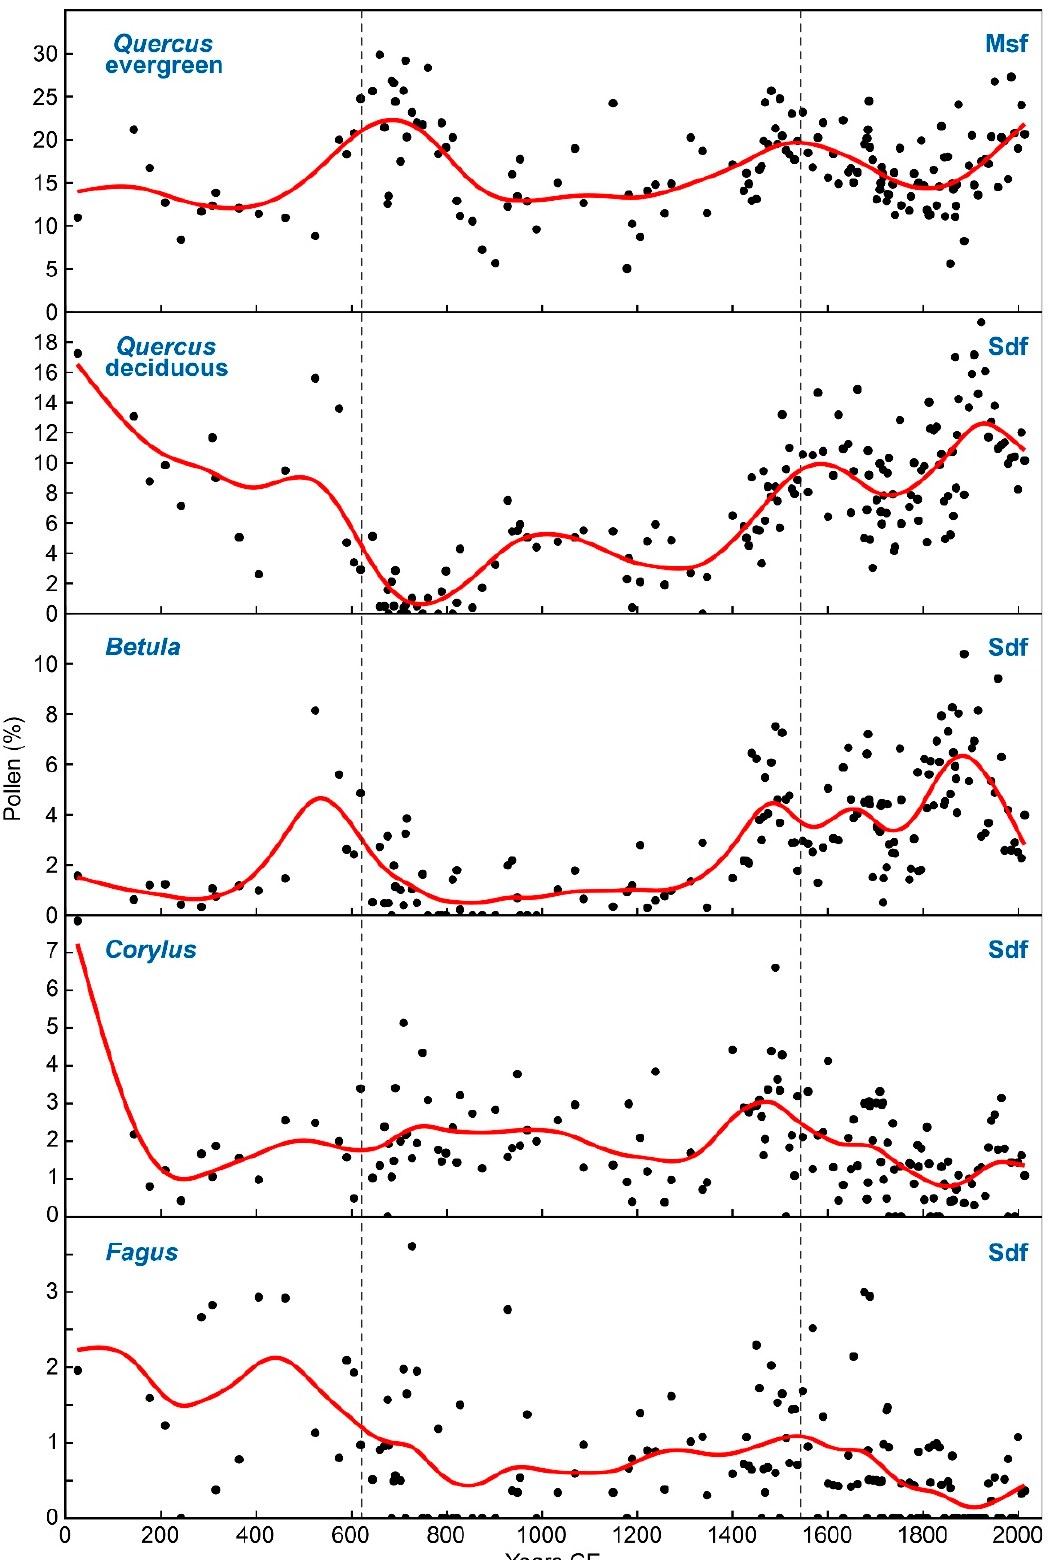
Figure 10. Pollen types of Mediterranean sclerophyll forest (Msf) and submontane deciduous forest (Sdf). Black dots: raw data, red line: smoothing spline.